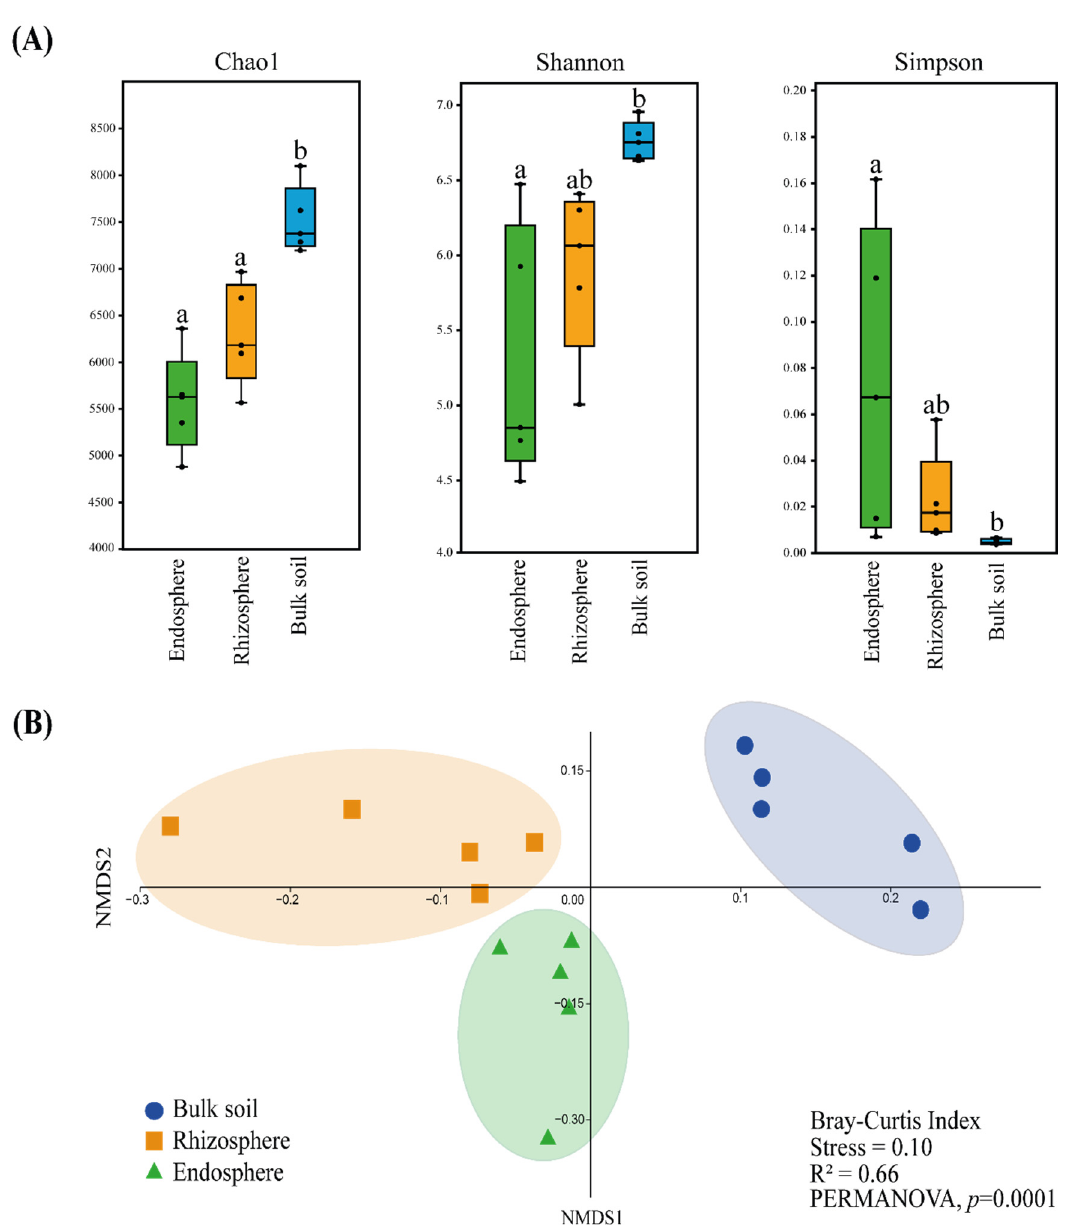
Figure 1. Diversity analyses of bulk soil (blue), rhizosphere (orange) and endosphere (green) bacteriomes associated with Tropaeolum majus . ( A ) Alpha diversity analyses. Different letters indicate significant differences (Tukey’s test, p < 0.05). ( B ) Beta diversity analysis represented in nonmetric multidimensional scaling (NMDS) generated in a 3D plot based on the Bray–Curtis dissimilarity